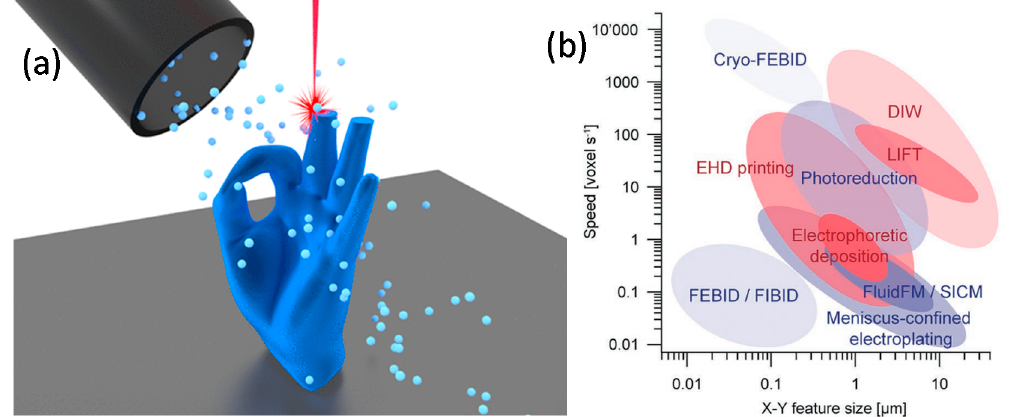
Figure 1. ( a ) Schematics of focused electron beam induced deposition (FEBID) for 3D nano-patterning, where gas injected by a nozzle is adsorbed on a substrate, with a fraction getting decomposed by a focused beam of electrons. By controlling the time the beam dwells on each point, 3D nano-printing of magnetic materials becomes possible. Reproduced with permission from [16]. Copyright 2020 American Chemical Society. ( b ) Comparison of speed and resolution of FEBID and its sister technique focused ion beam induced deposition (FIBID), with other emerging additive manufacturing methods for the direct writing of metallic micro- and nano- structures. FEBID at cryogenic temperatures (cryo-FEBID) enables direct-writing at very high growth rates, with slightly worse resolution [17,18]; a similar resolution as cryo-FEBID, with an approximately 100 increase in growth rate has been recently demonstrated using cryo-FIBID [19,20] (not shown here). Adapted with permission from [21].